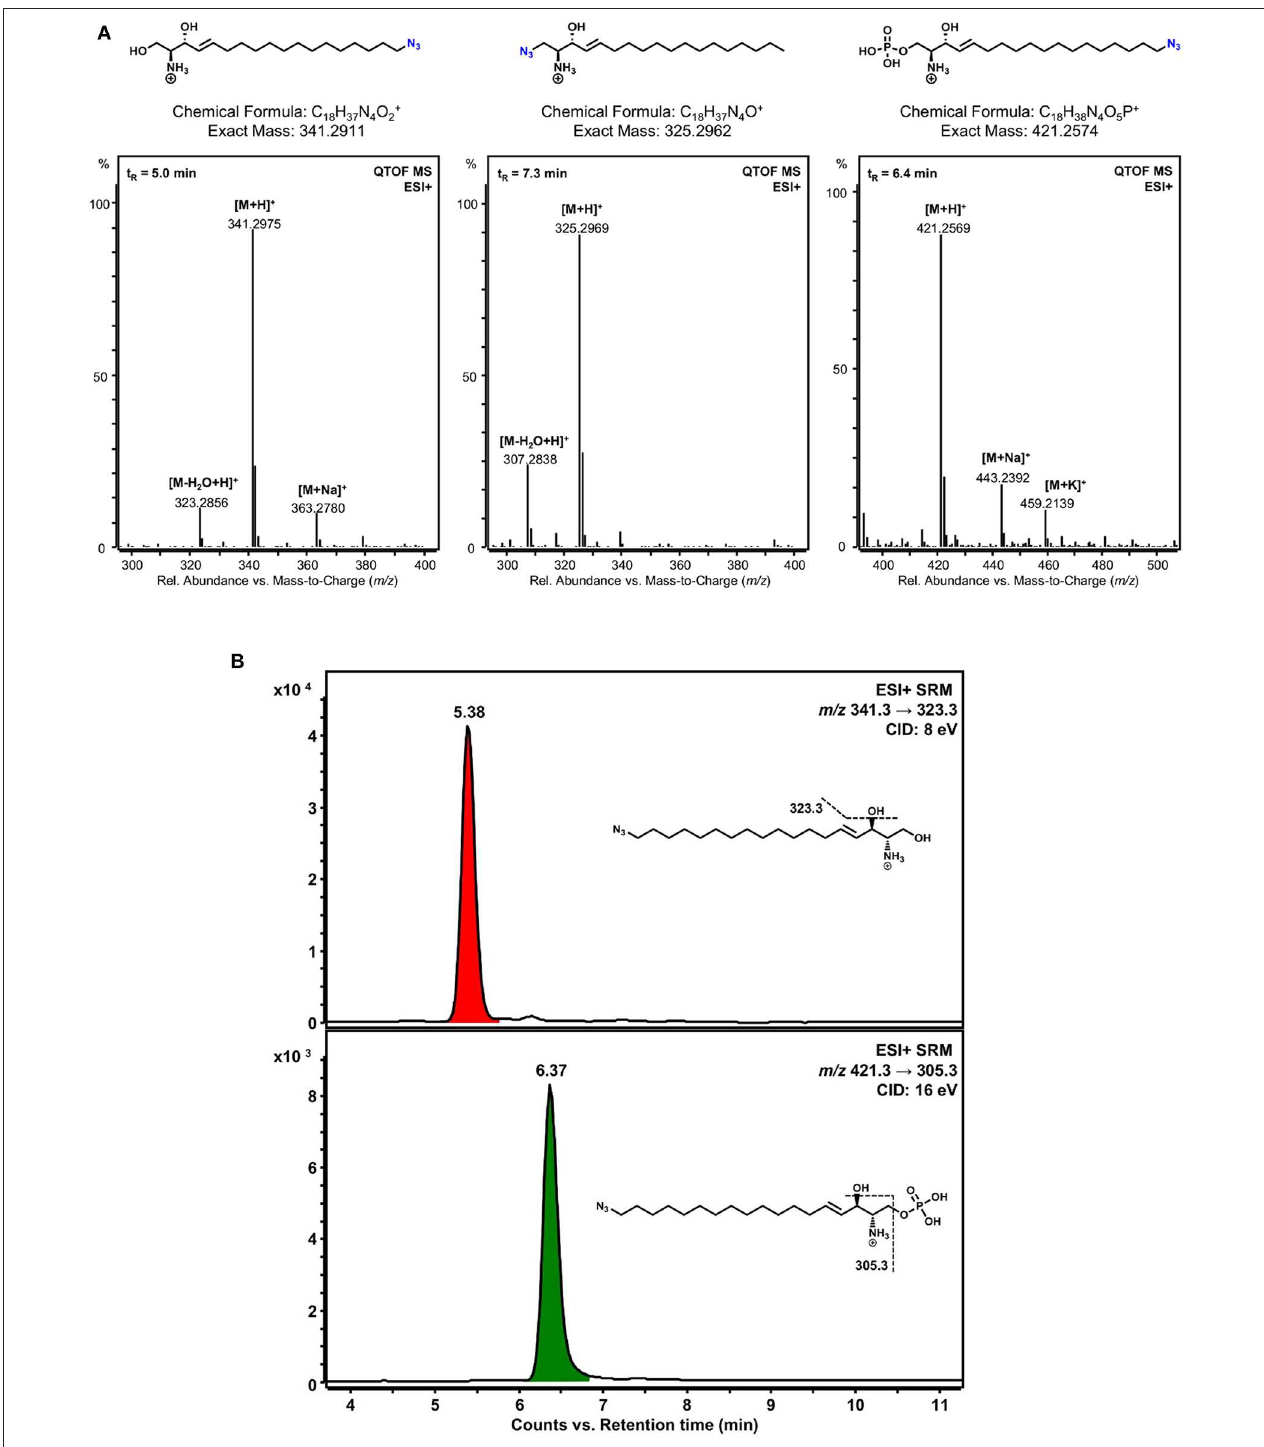
FIGURE 4 | Detection of phosphorylated sphingosine analogs. (A) LC-HRMS verification of the identity of the clickable sphingosine analogs used and detection of a phosphorylation product of ω -N 3 -sphingosine catalyzed by SphK1 in vitro . Lipid extracts from incubation of 1-N 3 -sphingosine or ω -N 3 -sphingosine with SphK1 and ATP were chromatographically separated by HPLC and analyzed with a quadrupole-time-of-flight mass spectrometer (QTOF MS) operating in the positive electrospray ionization mode (ESI + ). Chemical structures and mass spectra of ionized ω -N 3 -sphingosine (left), 1-N 3 -sphingosine (middle), and phosphorylated ω -N 3 -S1P (right) are shown. No phosphorylation product of 1-N 3 -sphingosine could be detected. The retention time (t R ) of each substance analyzed is given as inset